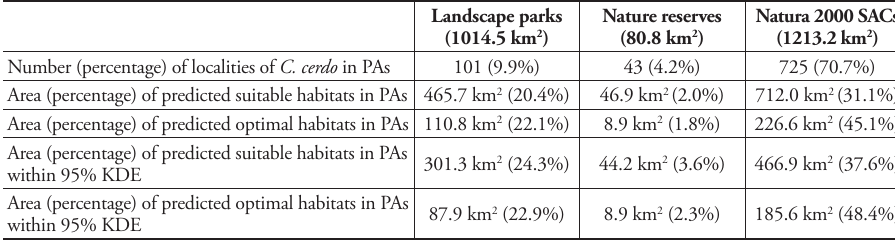
Table 3. Effectiveness of the systems of protected areas (PAs) in protecting Cerambyx cerdo L., 1758 in south-western